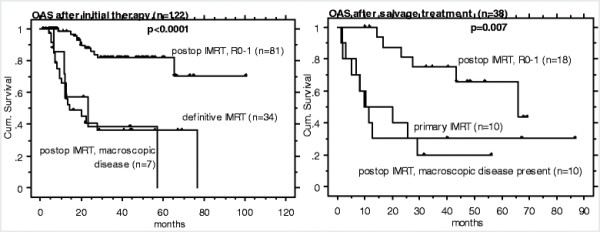
 OAS following IMRT in 122 patients with initial OCC diagnosis (left) and in 38 patients with salvage treatment of OCC recurrence following surgery alone (right).